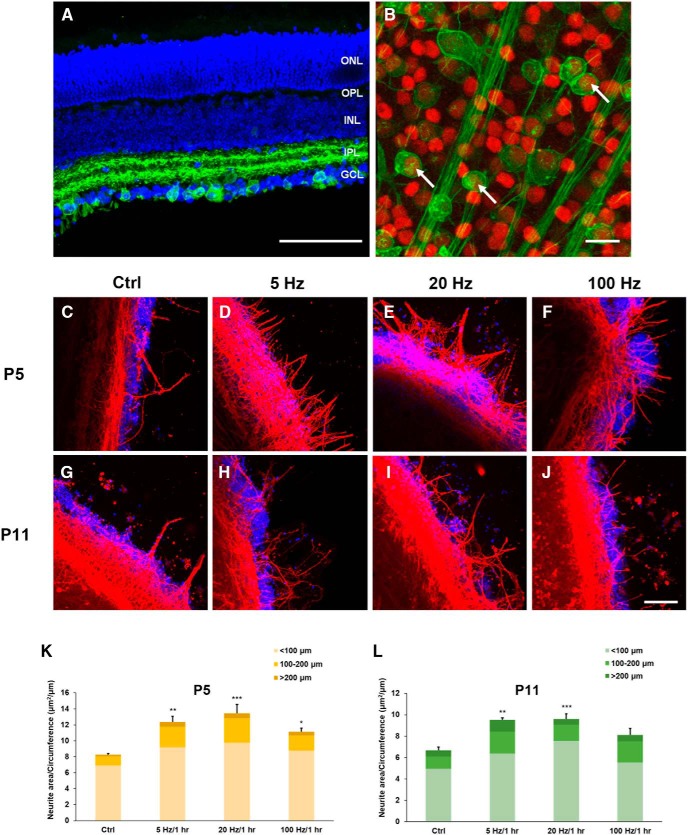
Blue light stimulation promotes neurite outgrowth of retinal explants from P5 and P11 mice with ChR2-expressed RGCs. A, A vertical section through the P11 ChR2 mouse retina. DAPI was used to indicate nuclei in the retinal slice (blue), and ChR2-eYFP cells were expressed exclusively in the ganglion cell layer (GCL) with their dendrites in the inner plexiform layer (IPL). Scale bar, 100 μm. B, ChR2-expressed RGCs in ChR2 mice were distributed randomly across the entire retina. Brn3a was used to label pan-RGCs (red), and ChR2-eYFP indicated ChR2-RGCs. White arrows show examples of RGCs expressing both Brn3a and ChR2. Scale bar, 20 μm. C–F, Confocal images of P5 retinal explants at DIV 5 with no light stimulation (Ctrl), and with 5, 20, and 100 Hz light stimulations for 1 h at the beginning of the experiment, respectively. G–J, Confocal images of P11 retinal explants at DIV 5 with the same treatments as the P5 retinal explants. All morphologically recognized neurites were TUJ1-positive (red), and DAPI was used to label the nuclei (blue). Scale bar, 100 μm. K, All three light stimulation protocols promoted neurite outgrowth in the P5 retinal explants (n = 5 for each condition). L, Similar results were obtained with the P11 retinal explants, except for the 100 Hz condition (n = 7 for the control; n = 5 for 5 Hz; n = 9 for 20 Hz; n = 6 for 100 Hz); *p < 0.05, **p < 0.01, ***p < 0.001. Error bars, mean ± SEM.